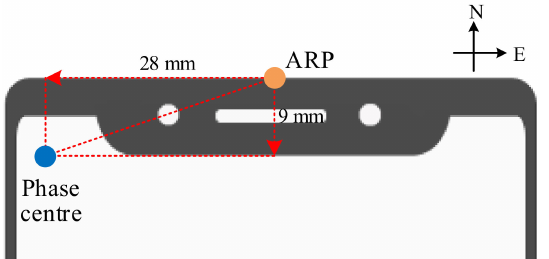
Figure 1. Diagram of global navigation satellite system (GNSS) antenna phase centre in Xiaomi Mi 8 smartphone [21].